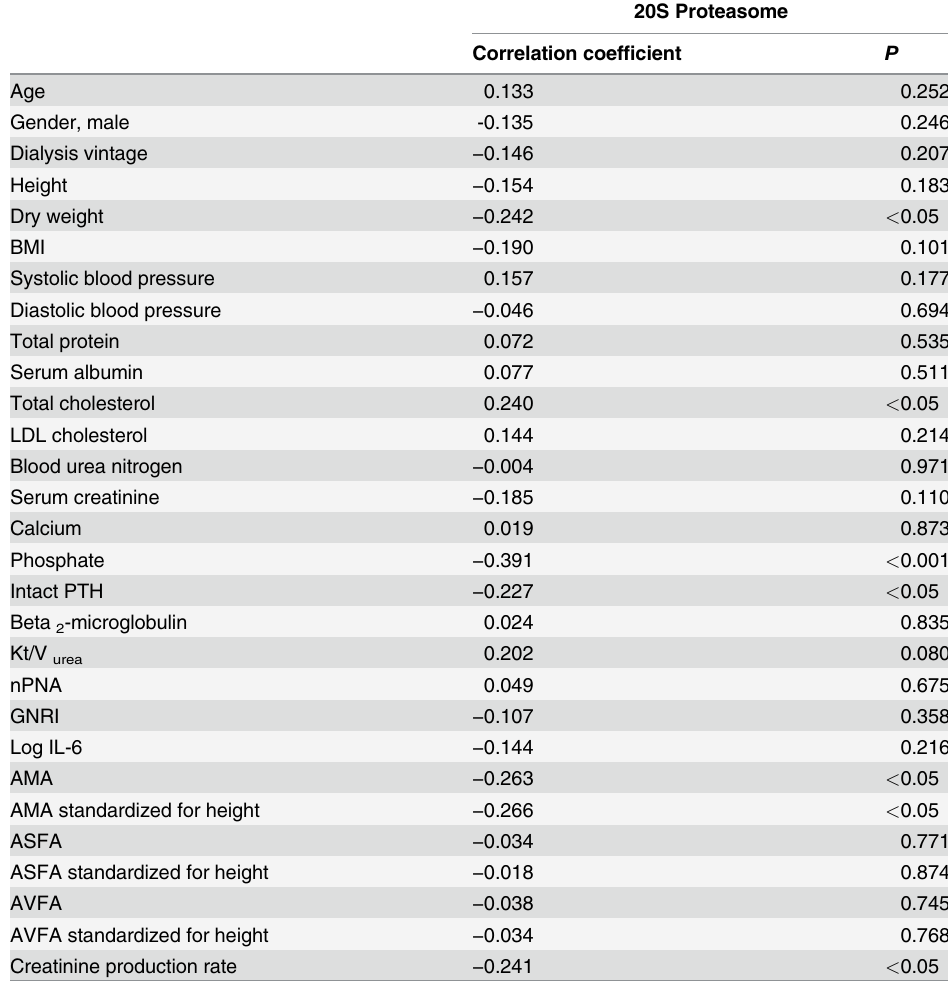
Table 2. Correlations between 20S Proteasome Concentrations and Clinical Variables.